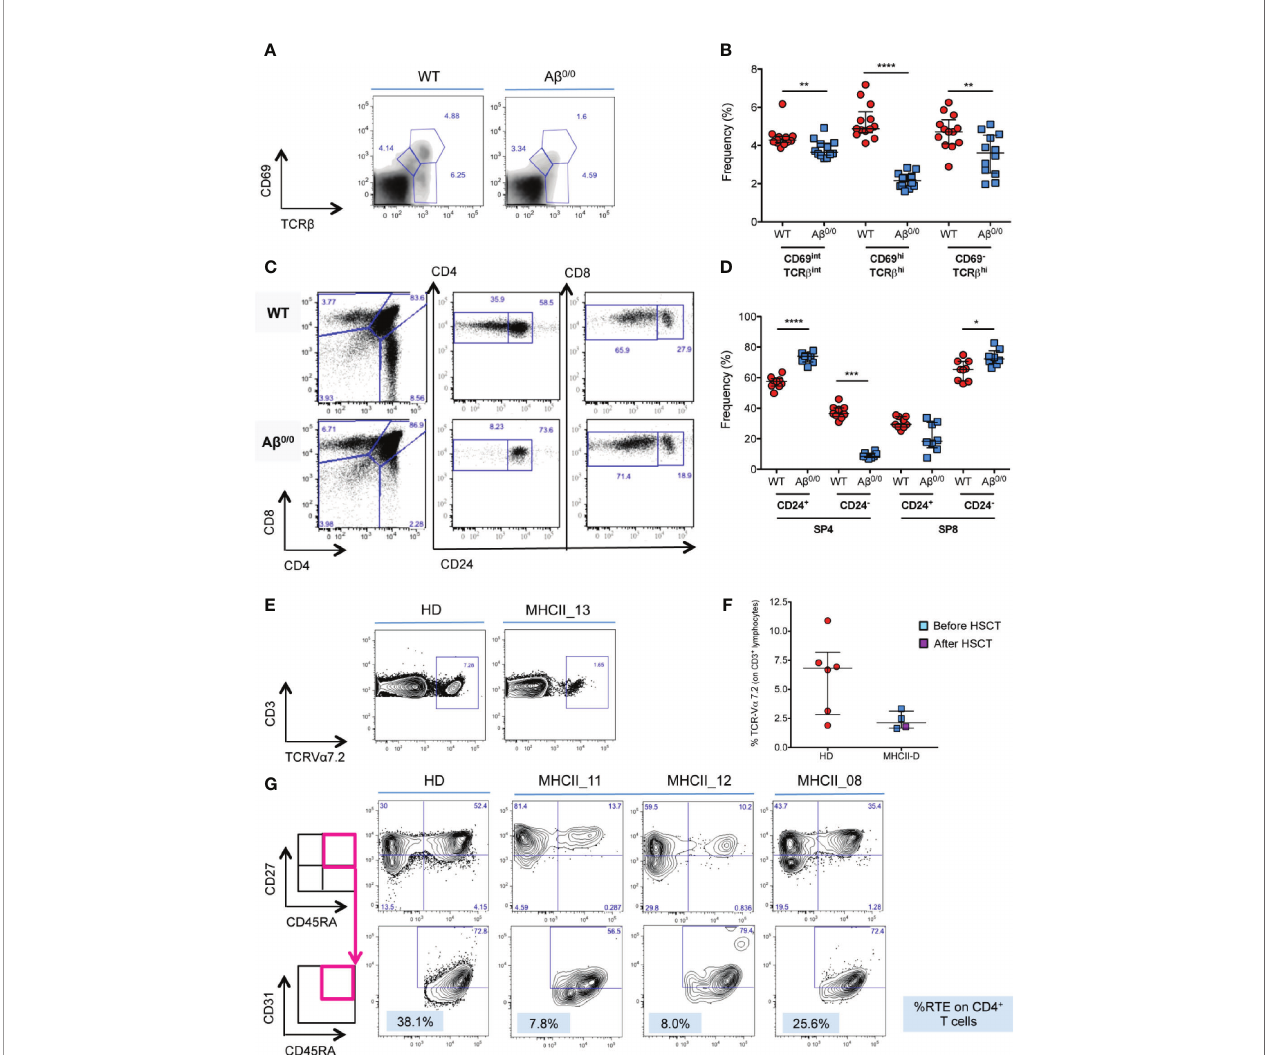
FIGURE 3 | Defective thymopoiesis in MHCII de fi ciency. (A) FACS analysis of thymocytes isolated from WT and A b 0/0 mice, in terms of CD69 and TCR b expression, shows an impaired positive selection of A b 0/0 thymocytes. Analysis performed on total thymocyte gate. (B) Graph shows the summary of all mice analyzed, showing a signi fi cant reduction in the frequency of CD69 hi TCR b hi post-positive selection thymocytes in A b 0/0 mice, as compared to WT. **p value < 0.01; ***p value < 0.001. (C) FACS analysis of thymocytes isolated from WT and A b 0/0 mice shows a normal development of CD4 − CD8 − double negative (DN) subsets. However, A b 0/0 mice CD4 + SP cells (SP4) mostly present an immature phenotype (CD24 + ), since only few of them are CD24 − , as compared to WT SP4 cells. (D) Graph shows the summary of all mice analyzed in terms of frequency of CD24 + and CD24 − SP4 and SP8 cells. *p value < 0.05; ***p value < 0.001; ****p value < 0.0001. (E, F) TCR V a 7.2 expression on CD3 + T cells is reduced in MHCII-D patients. (E) Representative FACS plots on V a 7.2 expression on CD3 + T cells on a healthy control (HD) and a MHCII-D patient (MHCII_13). (F) Graph shows the summary of all MHCII-D patients analyzed (n = 4) and the healthy controls (HD) tested in parallel. Median and interquartile range are represented for each group. (G) Representative FACS plots of CD4 + naïve T cells and recent thymic emigrants (RTE) of a healthy control (HD) and three MHCII-D patients, two before HSCT (MHCII_11 and _12) and one after HSCT (MHCII_08). CD27 + CD45RA + naïve T cells are gated on CD4 + CD3 + CD45 + T-cell gate, while CD31 + RTE are gated on CD27 + CD45RA + naïve T cell